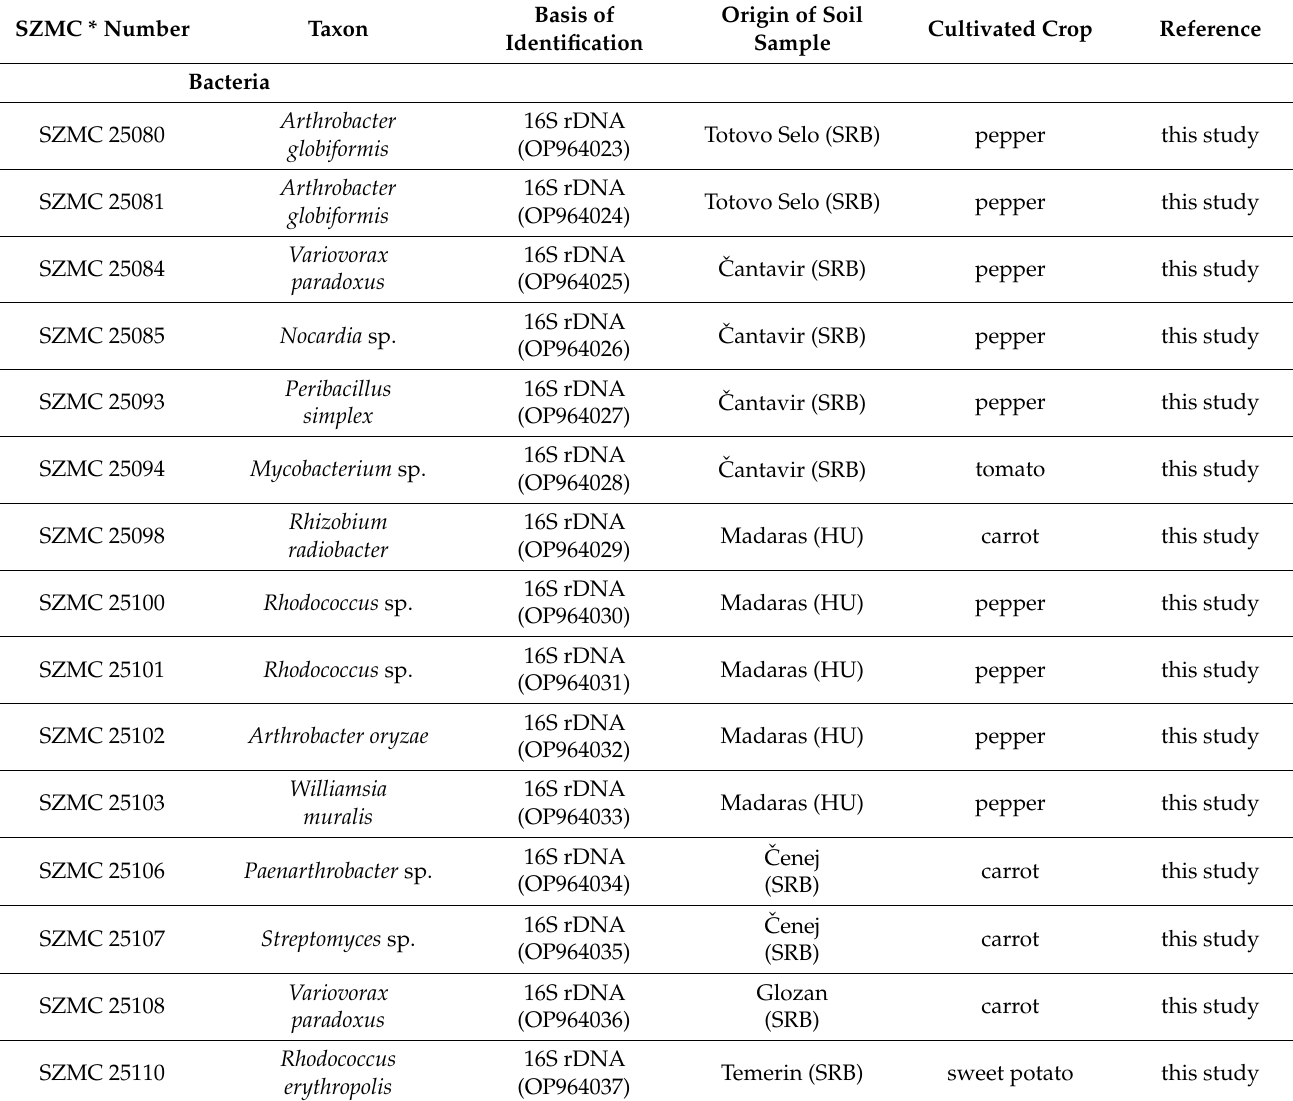
Table 1. Isolation and identification details of the microorganisms examined during this